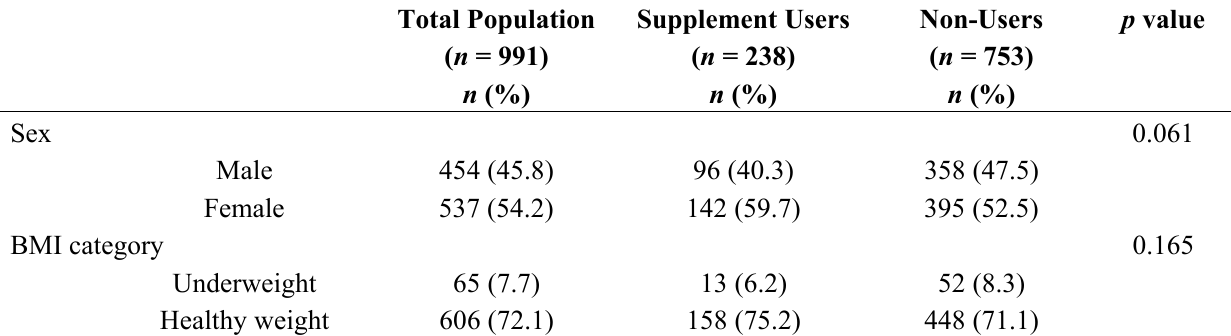
Table 1. Characteristics of 17 year old adolescents providing dietary intake data in the Western Australian Pregnancy Cohort (Raine)